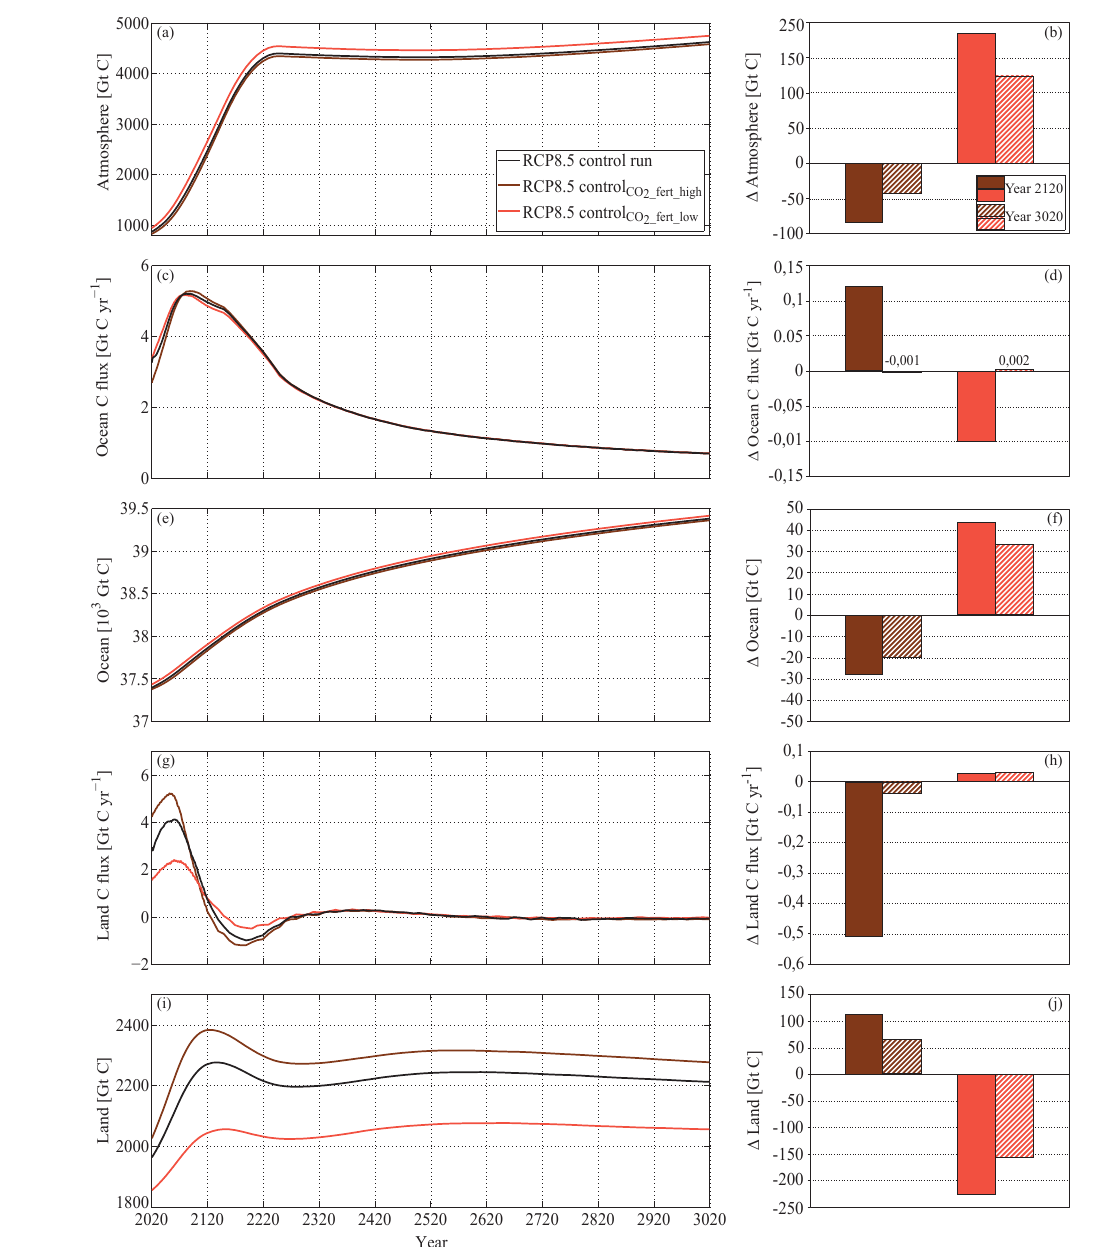
and RCP 8.5 control CO for 2 _fert_high 2 _fert_low (brown) (RCP 8.5 control CO , orange) and 2 _fert_high 2 _fert_low